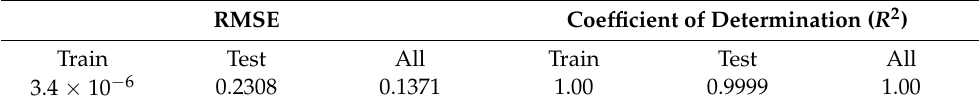
Table 1. Numerical metrics of the ANFIS model of the water electrocatalysis process. RMSE Coefficient of Determination ( R 2 ) Train Test All Train Test All